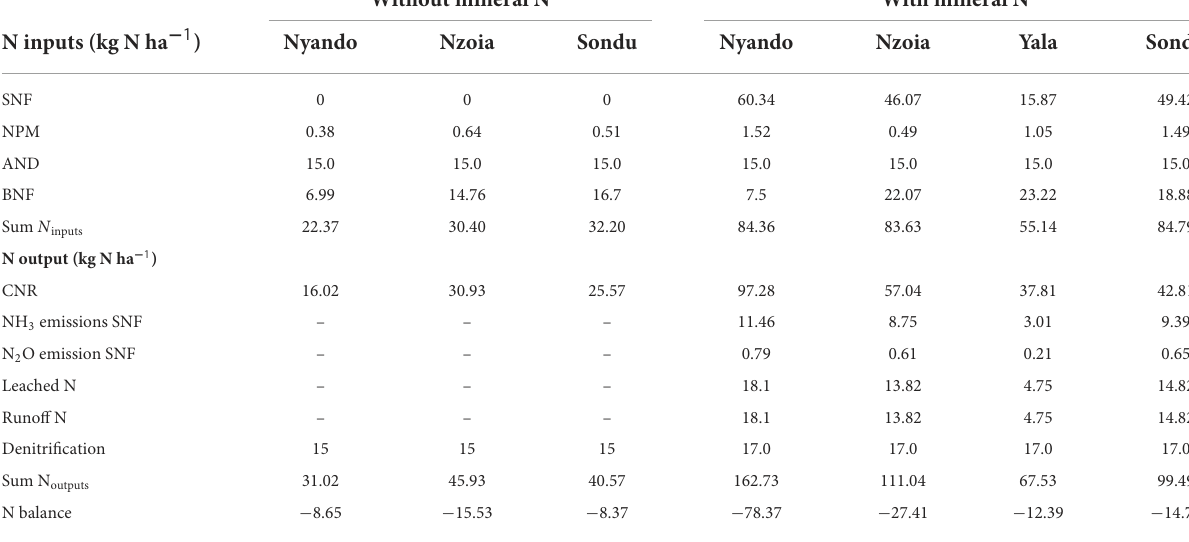
TABLE 4 Nitrogen budget for two categories of farms with and without mineral N applications. Without mineral N With mineral